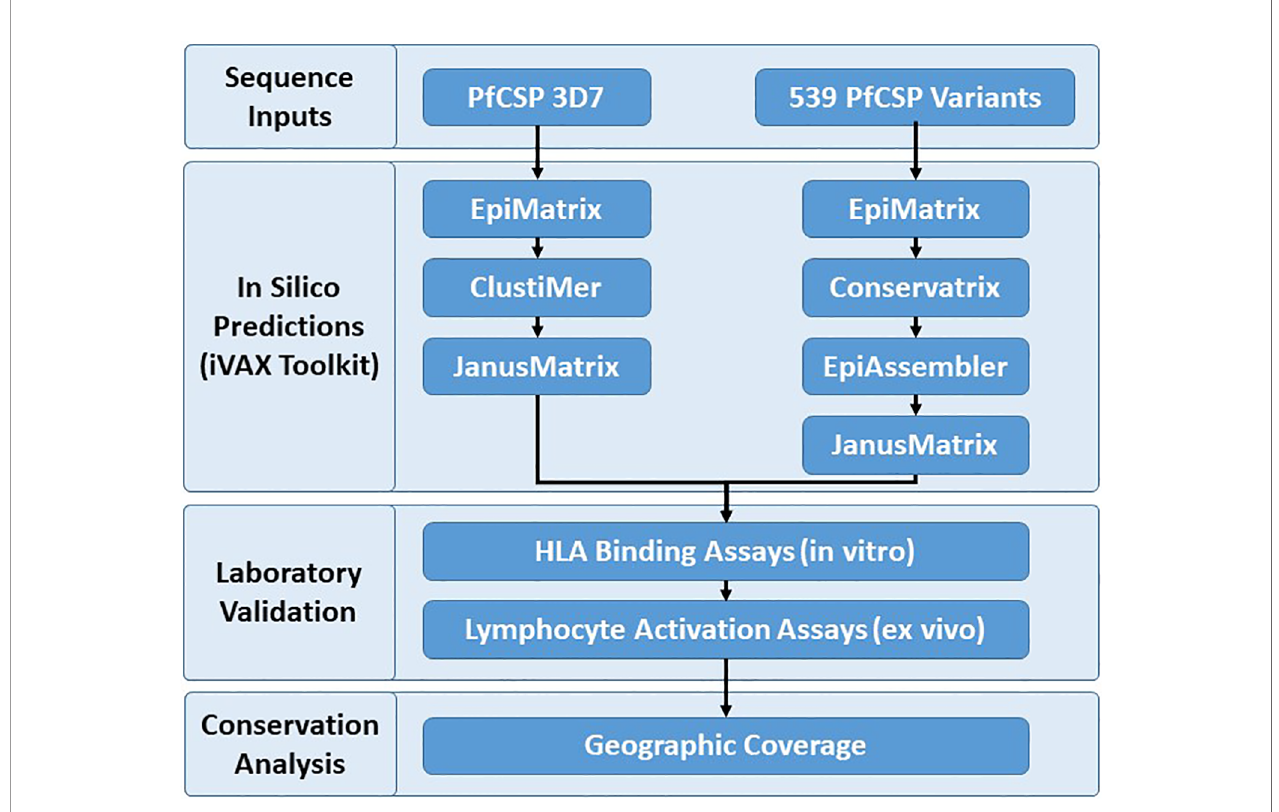
FIGURE 1 | Experimental Work fl